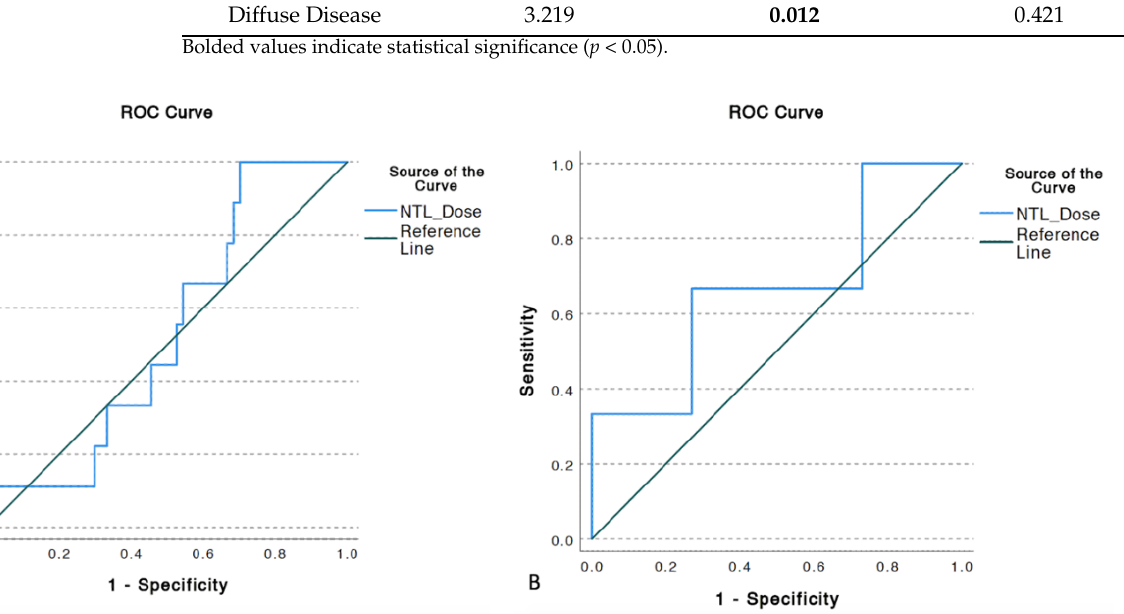
Table 4. Multivariate Analysis of Prognostic Factors.